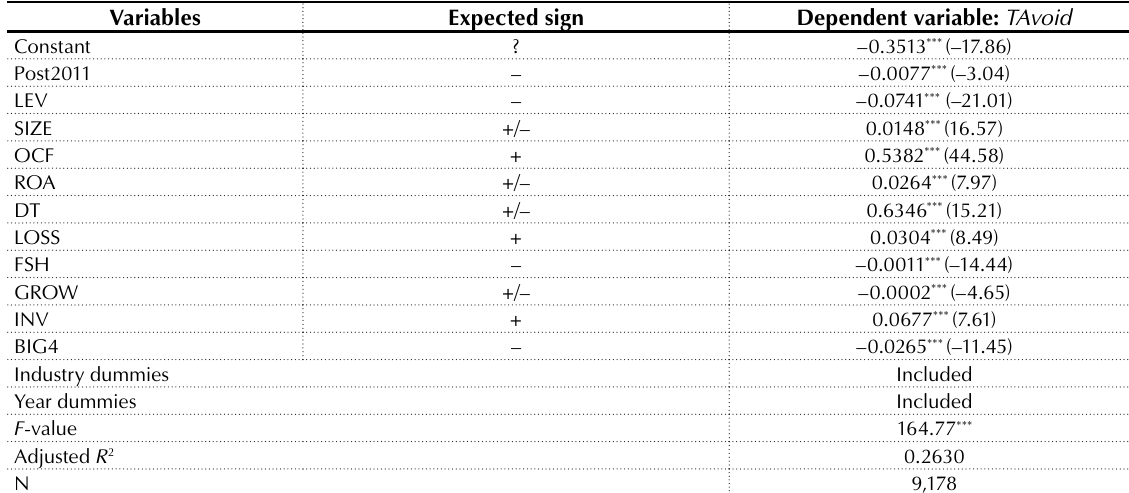
Table 4. Change in taxes after law change